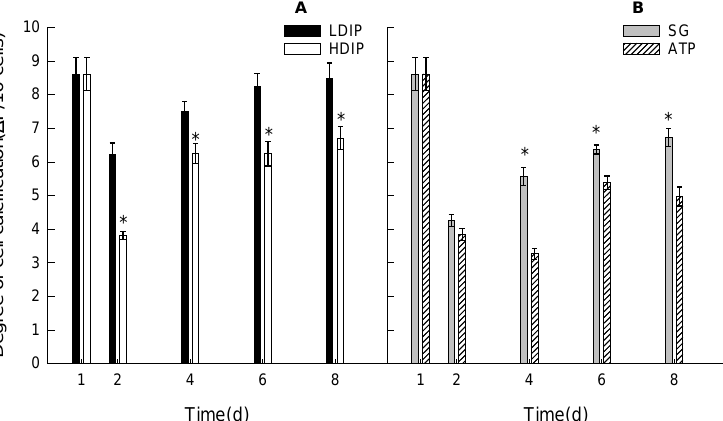
Figure 5. Changes in the relative extracellular calcification level of C. roscoffensis in the groups of inorganic ( A ) and organic ( B ) initial phosphorus resources. (LDIP): low concentration of inorganic phosphorus; (HDIP): high concentration of inorganic phosphorus; (SG): Na 2 -glycerophosphate; (ATP): adenosine triphosphate. * statistical significance, p < 0.05.